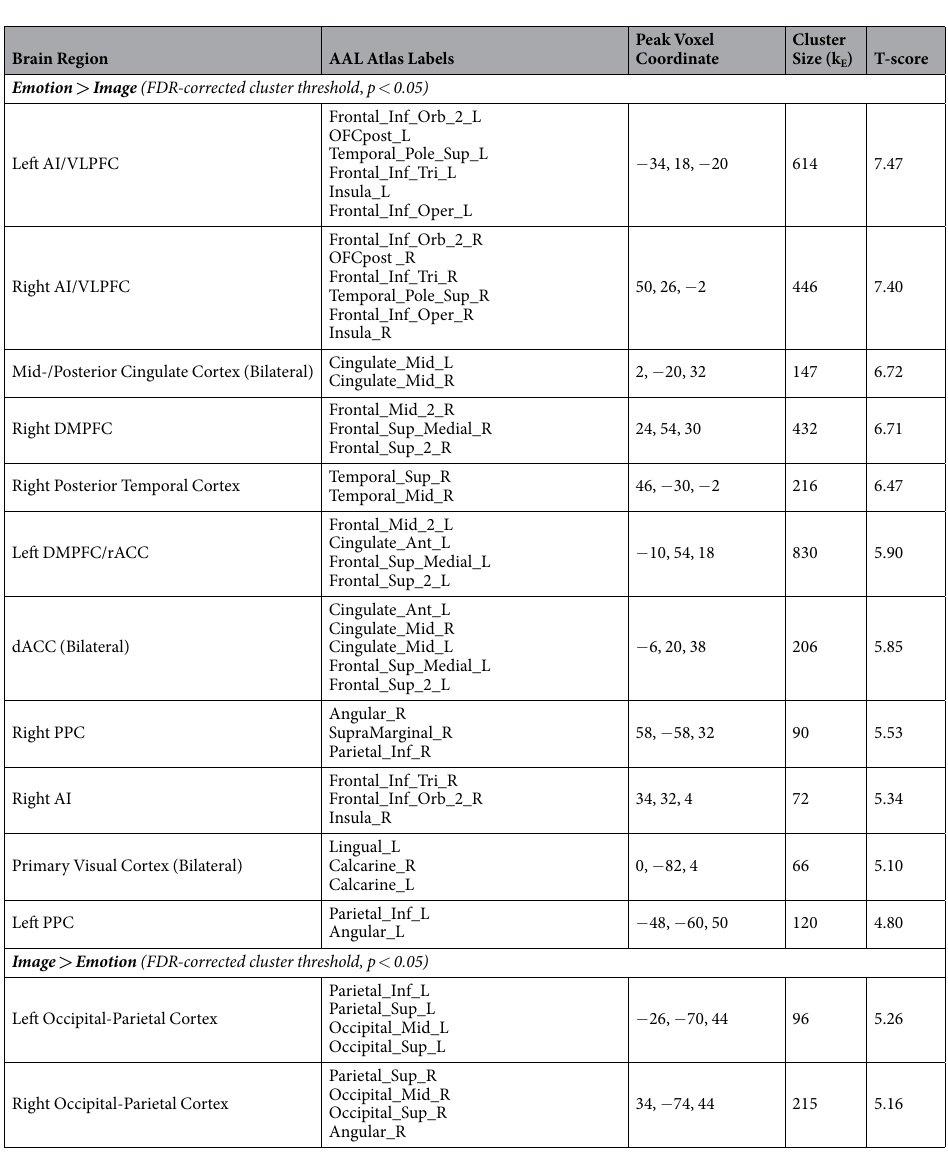
Table 1. fMRI Results: Emotion vs.